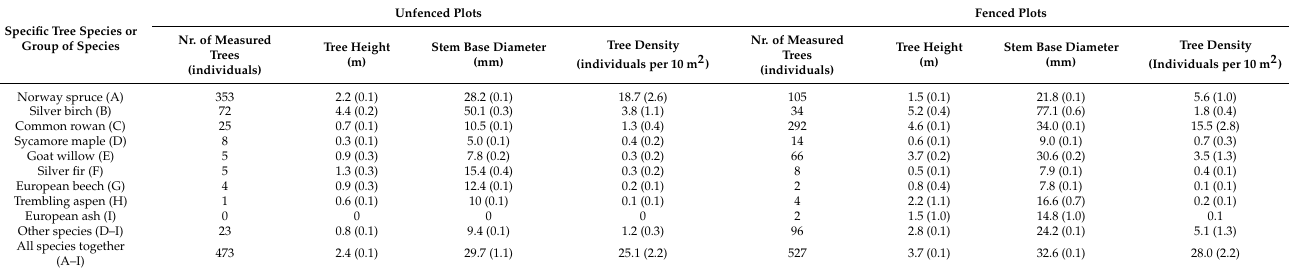
Figure 2. Tree height ( a ), stem base diameter ( b ), number of trees ( c ), and aboveground biomass ( d ) on unfenced and fenced plots in the study area in the Kyusce region, northern Slovakia. Different letters indicate significant differences (two-way ANOVA followed by Fisher’s LSD test, see also Table 3). Table 2. Mean (SE) tree characteristics on the plots outside of a fenced area and exposed to browsing by large wild herbivores and inside a fenced area protected from herbivory in the Kysuce region, northern Slovakia, during the growing season of